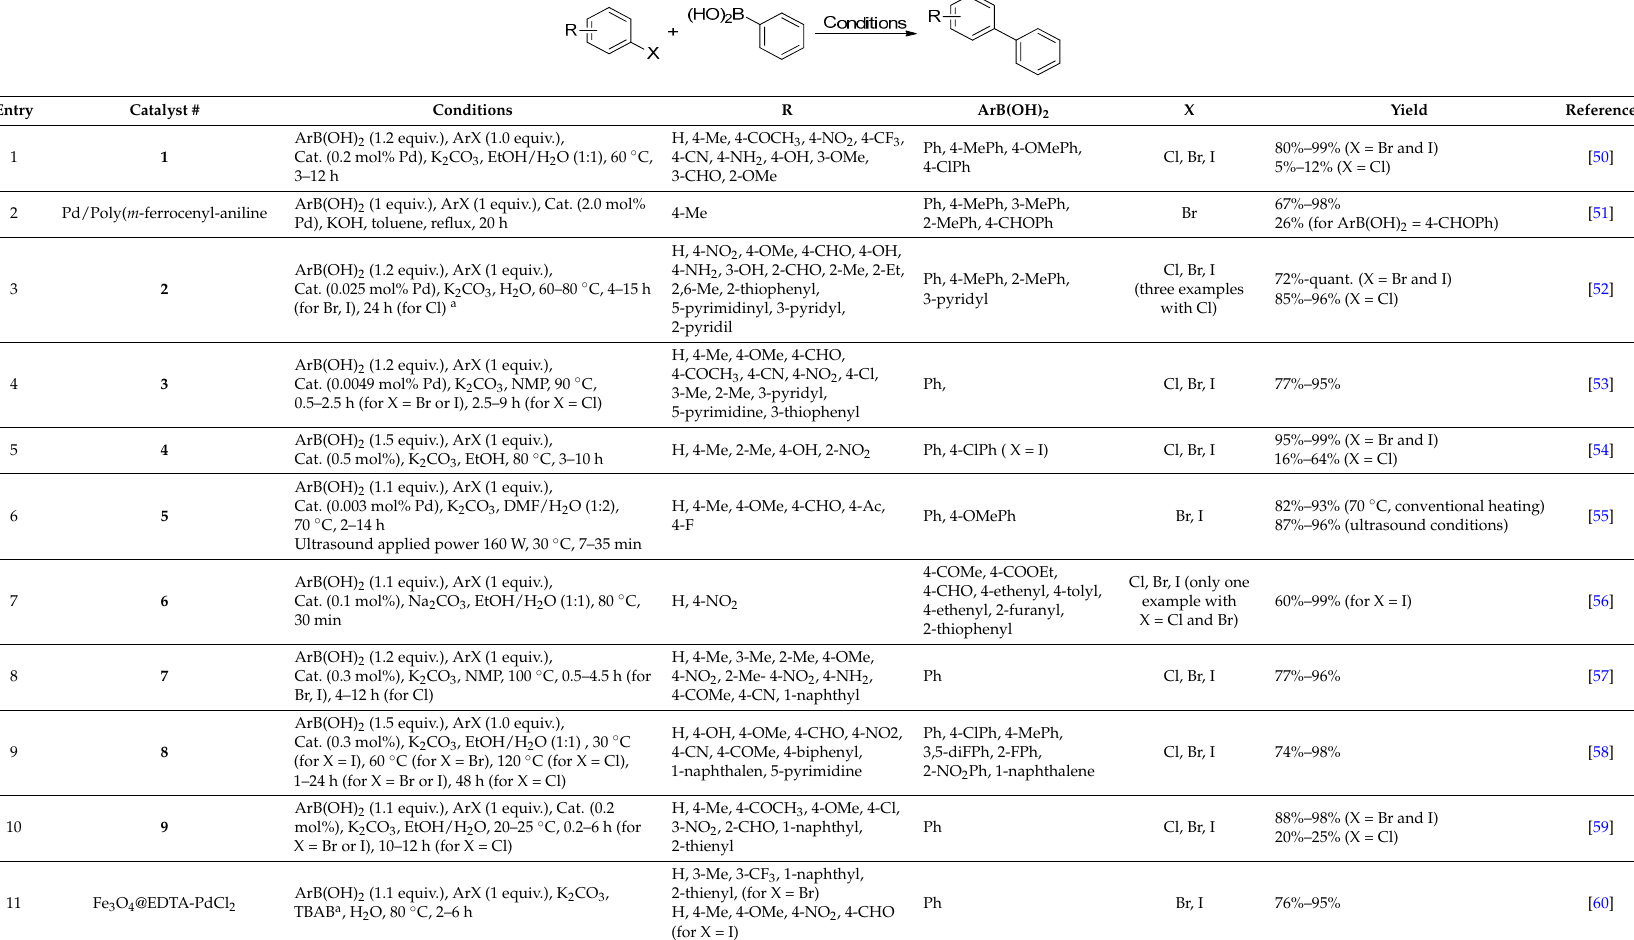
Table 2. Use of palladium catalyst chelated to magnetic nanoparticles as catalysts for Suzuki–Miyaura cross-coupling.